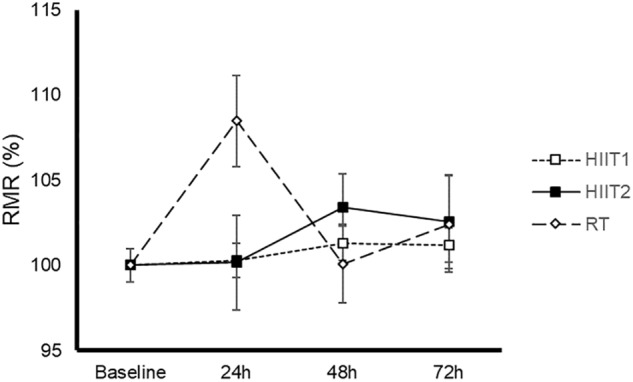
Time-course of resting metabolic rate (RMR) after a session of high-intensity interval training with short (HIIT1) or long intervals (HIIT2), or resistance training (RT). Data are mean ± standard error. No significant time (p = 0.164) or condition (HIIT1, HHT2 or RT) by time interaction effect (p = 0.058) was found. Abbreviations: HIIT1, high intensity interval training session with short intervals; HIIT2, high intensity interval training session with long intervals; RT, resistance training.